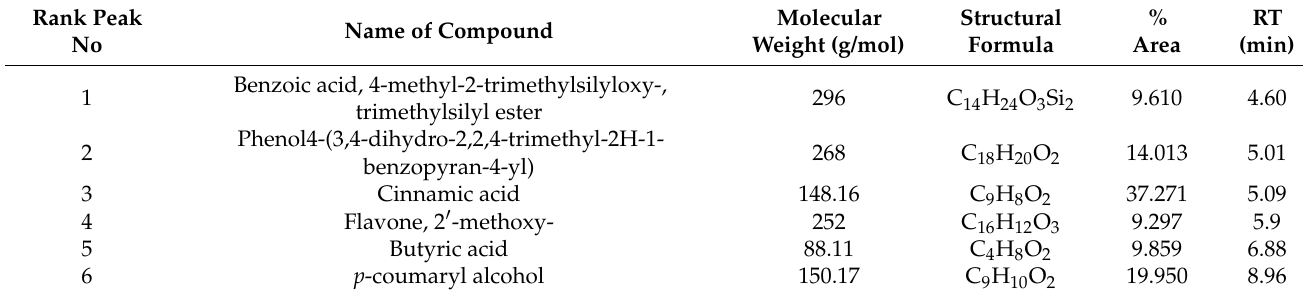
Table 2. GC-MS identified compounds in the polyphenol-rich fraction of C. europaea . Rank Peak